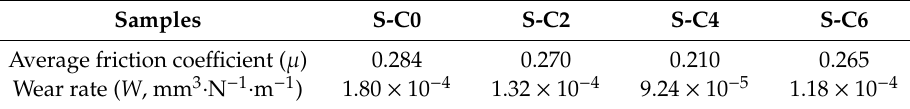
Figure 7. Friction coe ffi cient and wear rate of the nanocomposite coatings, ( a ) kinetic curves of the friction coe ffi cient, ( b ) average friction coe ffi cient and wear rate. Table 2. Average friction coe ffi cient and wear rates of nanocomposite